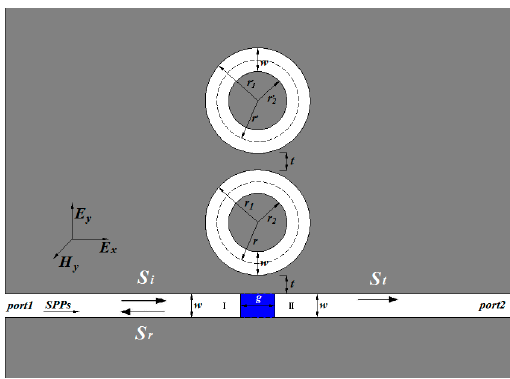
Figure 5. Schematic of the structure composed of two series-wound ring resonators with two waveguides.